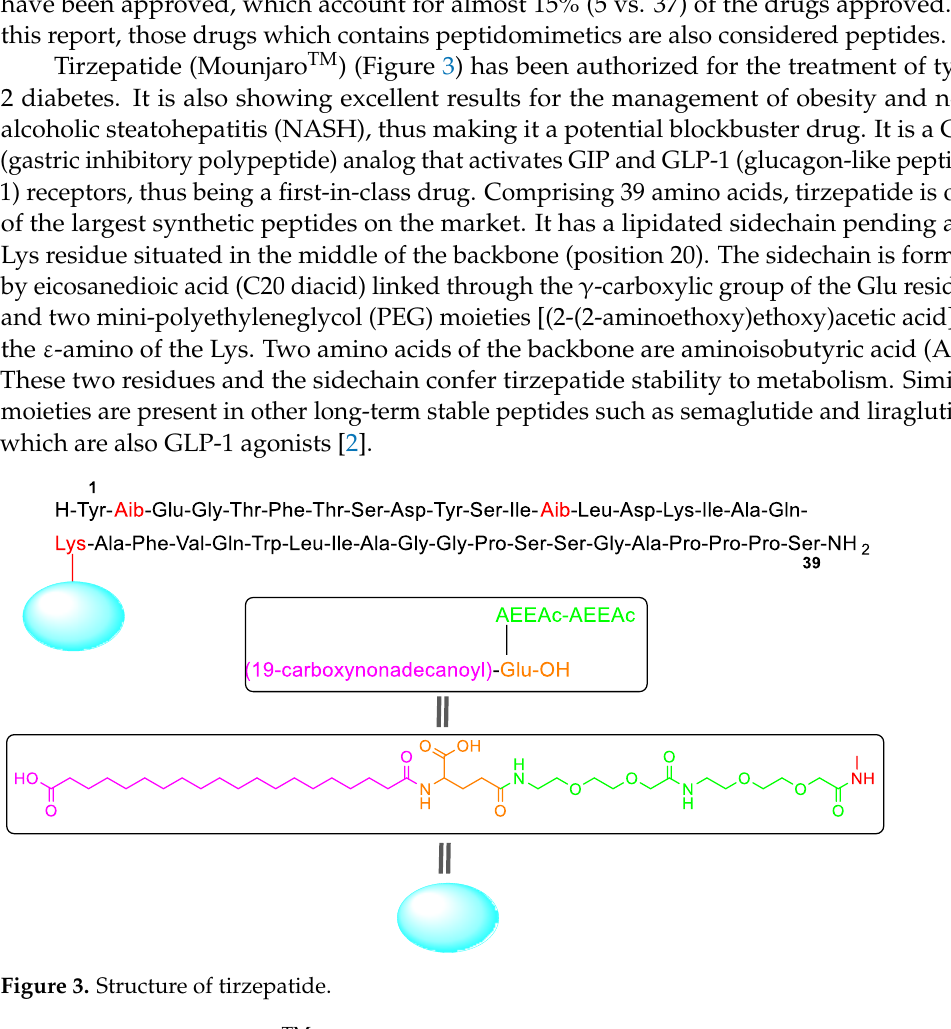
Figure 4. Structure of terlipressin (in pink the sequence of lypressin).